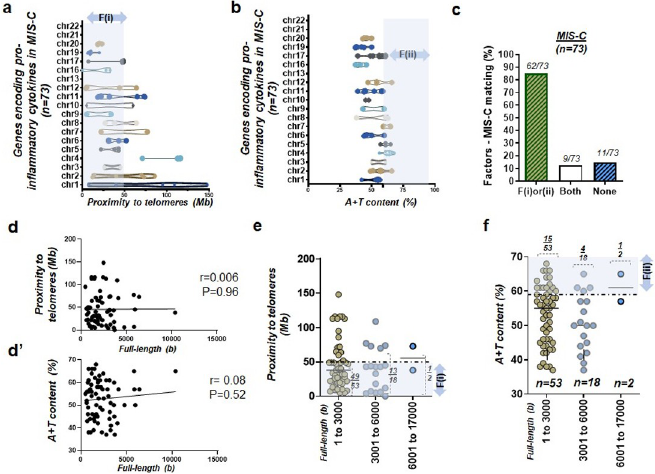
Fig 3. Genes (n = 73) encoding pro-inflammatory cytokines in MIS-C. (a) Box and violin plots displaying the distribution of genes encoding pro-inflammatory cytokines in MIS-C with respect to proximity to telomeres over chr 1 to 22. F(i) indicates distance to the telomere (b) Box and violin plots summarizing the full distribution of genes encoding pro-inflammatory cytokines with respect to A+T content over chr 1 to 22. F(ii) indicates A+T content if higher than 59%. (c) Bar graph demonstrating factors-disease (MIS-C) matching rate. Total number of genes, n = 73, with 85% match (62 of 73) of factor (i) or (ii) with MIS-C. (d) Scattered plot exhibiting the Pearson correlation between the full length (base or b) of genes encoding pro-inflammatory cytokines and their proximity to telomeres. Poor correlation (r = 0.006) with the level of statistical significance at P = 0.96. (D’) Scattered plot showing the Pearson correlation between the full length (base or b) of genes encoding pro-inflammatory cytokines and A+T content. Poor correlation (r = 0.08) with the level of statistical significance at P = 0.52. (e) Scatter plot showing proximity to telomeres of 73 genes encoding pro-inflammatory cytokines in MIS-C with respect to three sub-groups of the gene size by full- length in base or b. A horizontal dotted line indicates 50 Mb. The level of statistical difference after one-way ANOVA among three groups of 1 to 3000, 3001 to 6000, and 6001 to 17000 at P > 0.05. (f) Scatter plot summarizing A+T content of genes encoding pro-inflammatory cytokines in MIS-C with respect to the gene size in base or b. A horizontal dotted line indicates 59%. The statistical difference after one-way ANOVA among three groups of 1 to 3000, 3001 to 6000, and 6001 to 17000 at P > 0.05. F(i) and F(ii) indicate the first and second factor, respectively (a, b, e, and f).